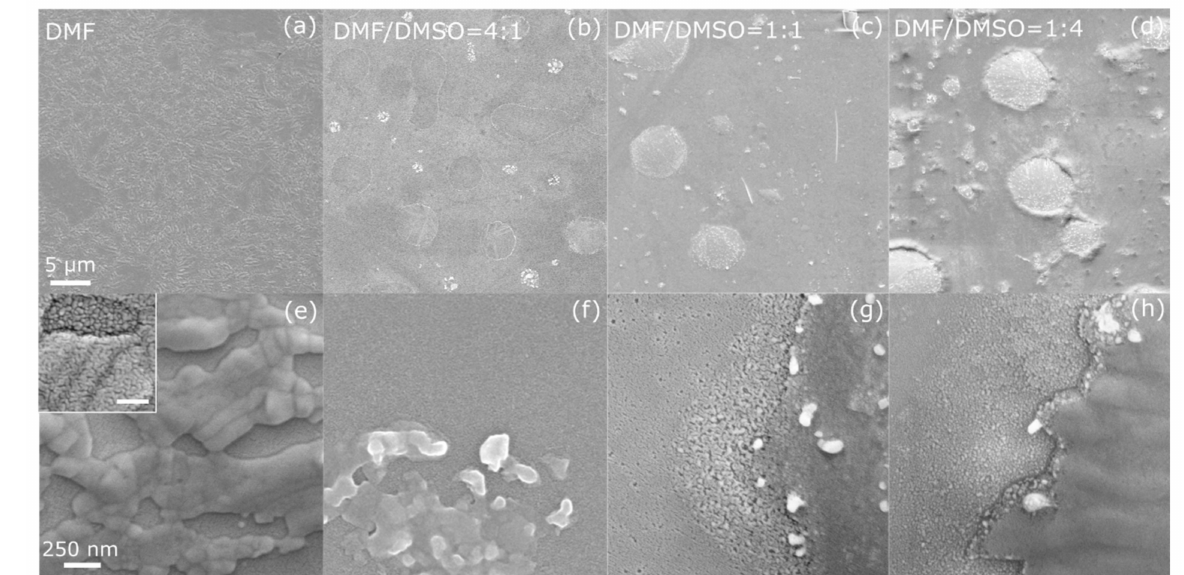
Figure 9. Scanning electron micrographs of annealed (PRSH)PbBr 3 films prepared in DMF and in DMF/DMSO mixtures, taken at low ( a – d ) and high ( e – h ) magnification. The scale bars in the left panels apply to all micrographs. The inset in ( e ) shows a high magnification micrograph of the underlying film in ( a ) (the scale bar corresponds to 100 nm).